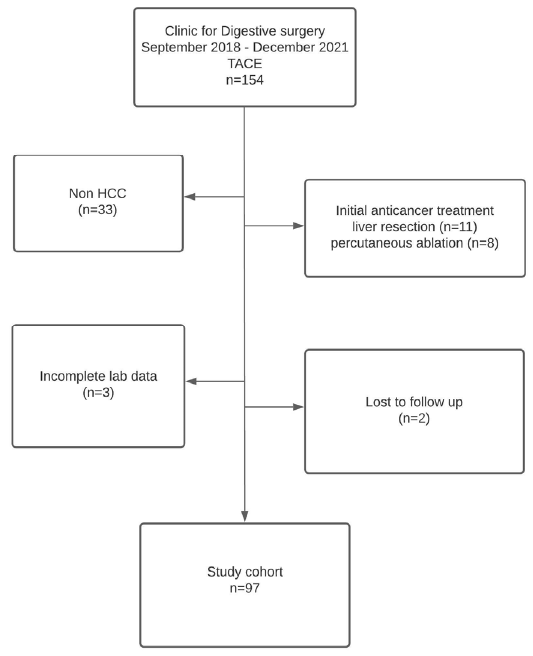
Figure 1. Patients Flowchart.